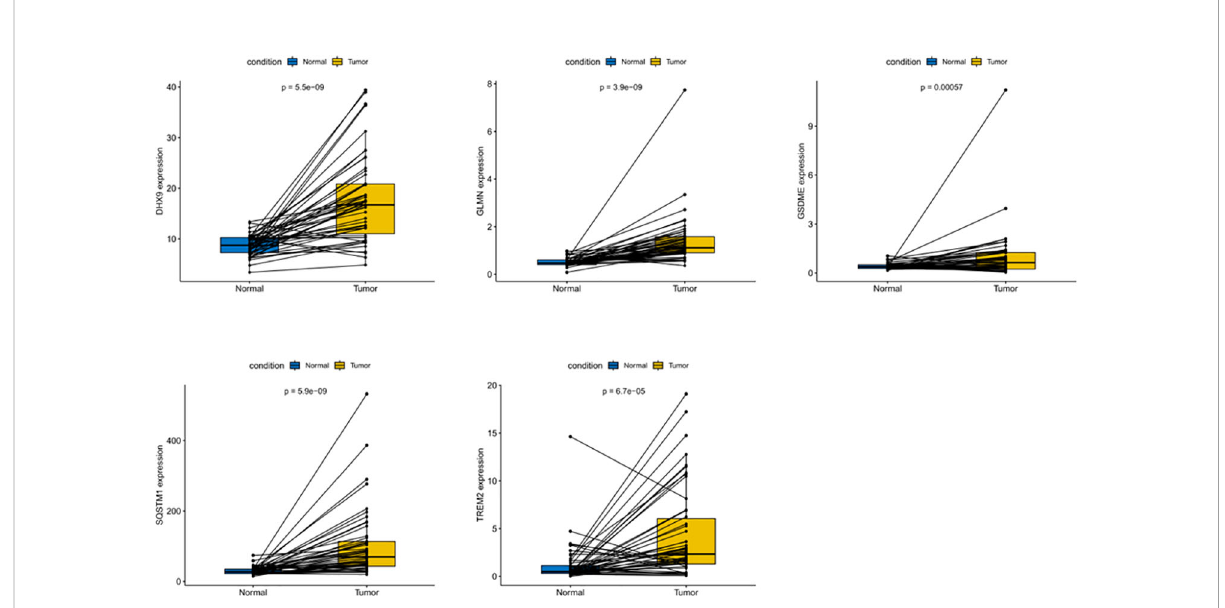
FIGURE 9 Differential expression of fi ve DEGs in HCC and adjacent normal